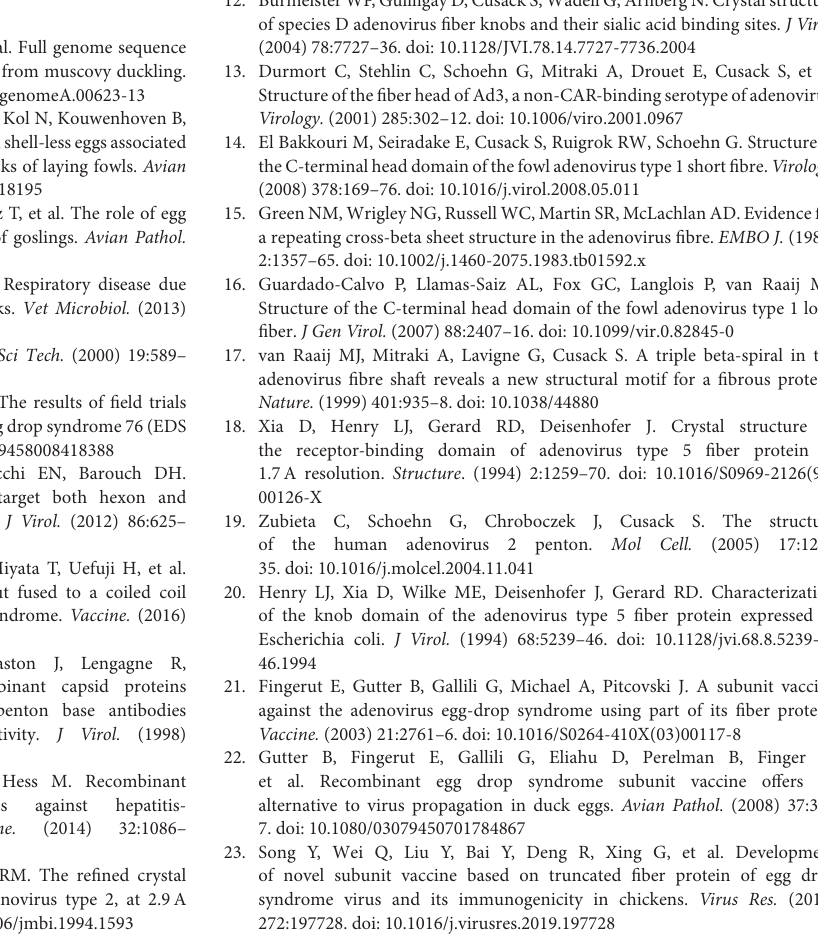
Supplementary Figure 1 | Schematic diagram of the expression plan for fiber protein. The amplified PCR fragment of the fiber gene was cloned into pET28a plasmid and then transformed into E. coli ; the positive clone was cultured in LB medium by adding IPTG. The cell pellets resuspended were lysed by sonication and then centrifuged to remove the insoluble pellet. After that, the fiber protein was purified according to the instruction of Ni-NTA purification